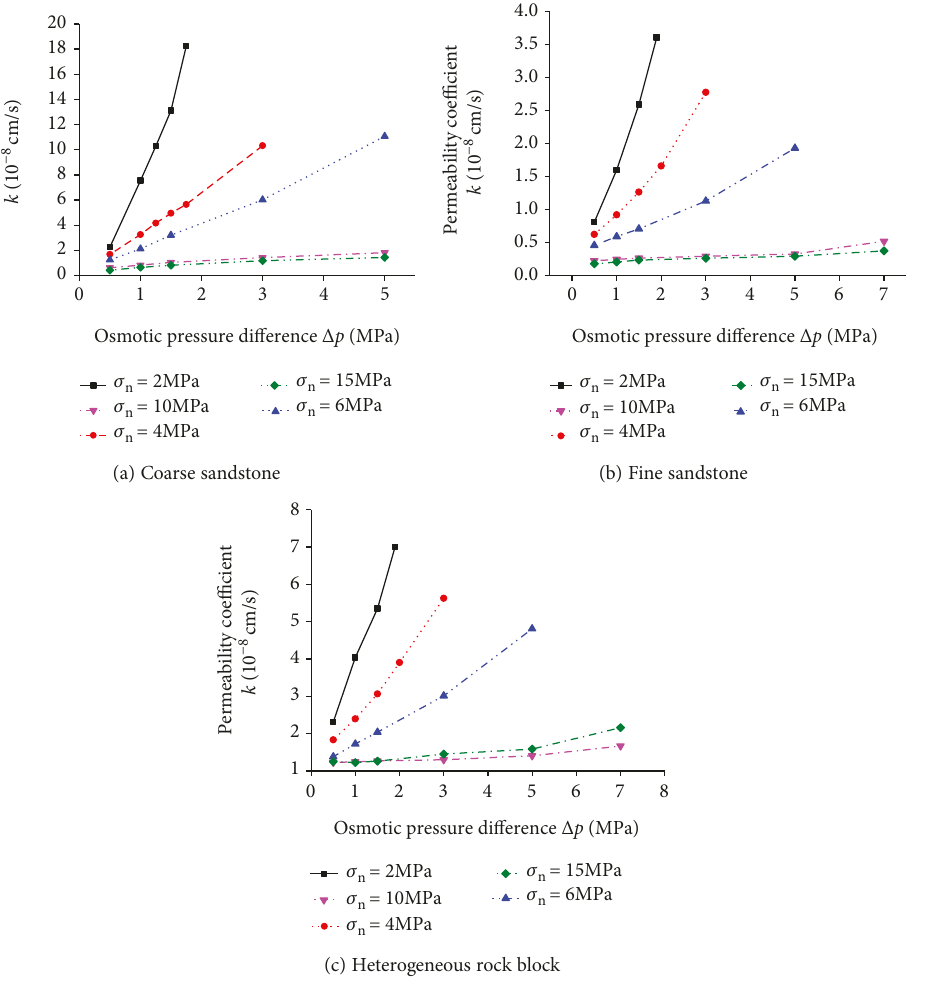
Figure 7: Relationship between permeability coe ffi cient and osmotic